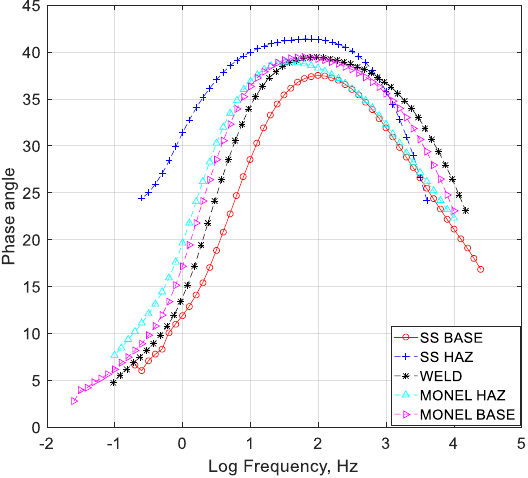
0.99 Figure 18. Schematic representation of the equivalent electric circuit. Table 4. Summary of resistance and capacitance of equivalent circuit. Specimen